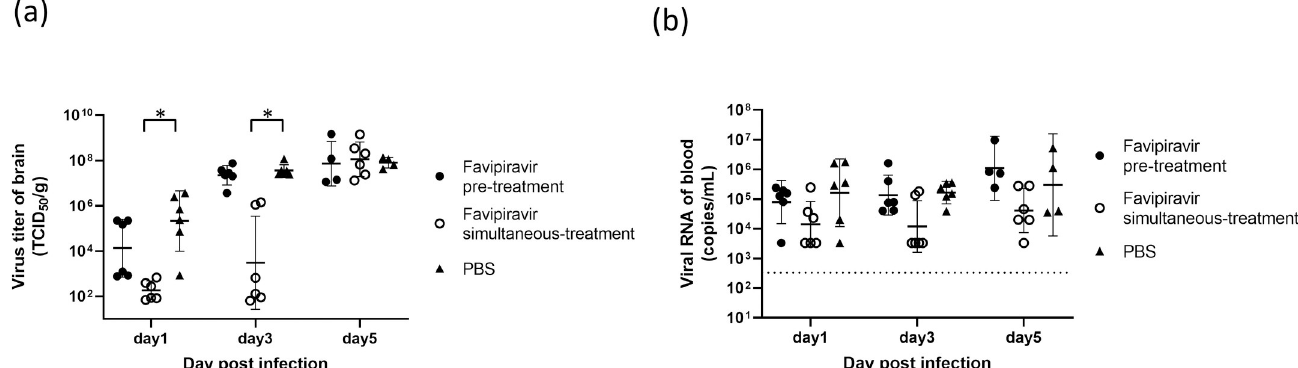
Fig 4. Analysis of the virus titers in the brain and blood viral RNA levels in JCV-infected C57BL/6J mice treated with FPV and PBS. Mice (4–6/group) were inoculated intracerebrally with 1.0 × 10 4 TCID 50 JCV. FPV (300 mg/kg/day) and PBS treatments were initiated 2 days prior to virus inoculation (pre-treatment) or on the same day of virus inoculation (simultaneous-treatment) and continued for 5 days. The virus titers in the brain (a) and the blood RNA levels (b) in JCV- infected C57BL/6J mice, 1, 3, and 5 dpi are shown. The data are obtained from a single experiment. Each bar represents the geometric mean with the geometric standard deviation. The dotted line indicates the limit of detection of RT-qPCR. Asterisks denote significant differences (p < 0.05).